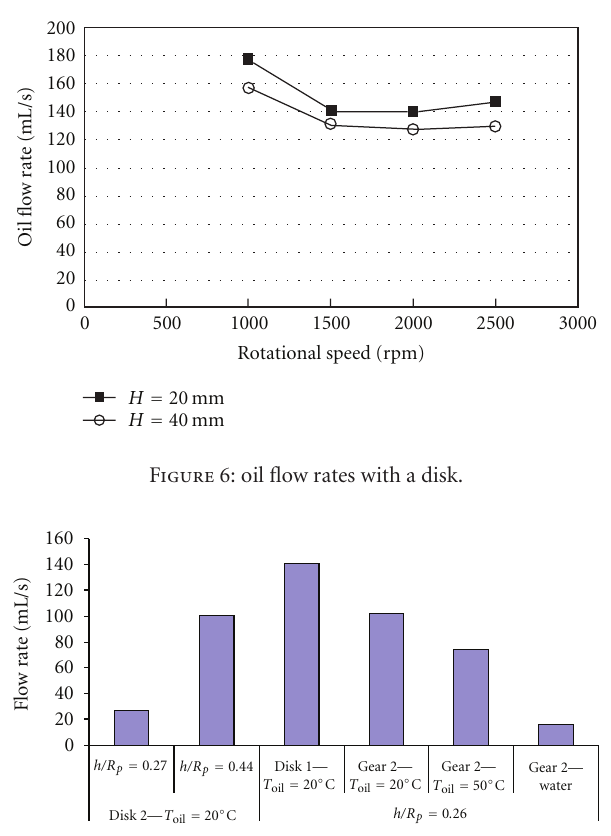
Figure 7: Influential parameters on flow rate.